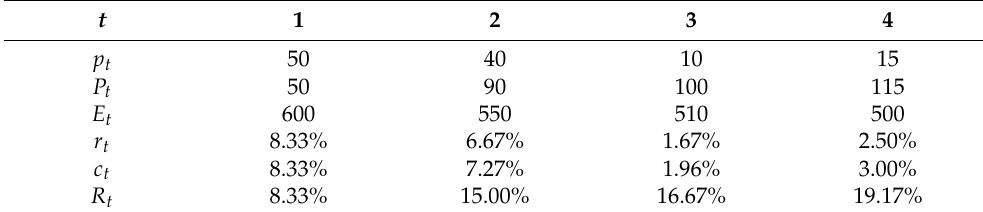
Table 7. Portfolio ( EAD = 600 ) performance in 4 years ( T = 4 ).